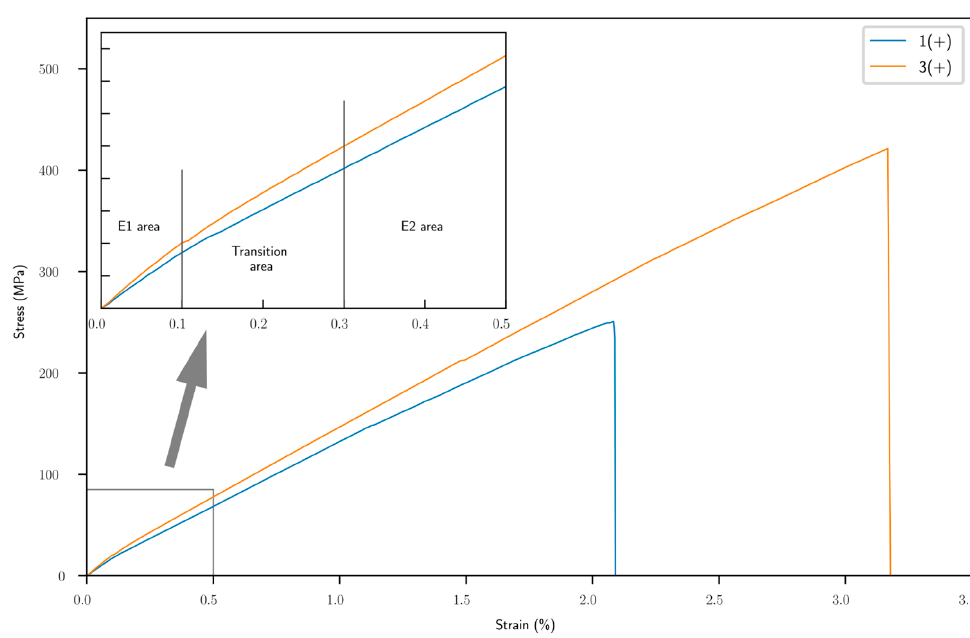
Figure 4. Tensile stress–strain curves of biobased composites; zoom on the small deformation area (until 0.5%). Blue line is 1 (+), orange line 3 (+).